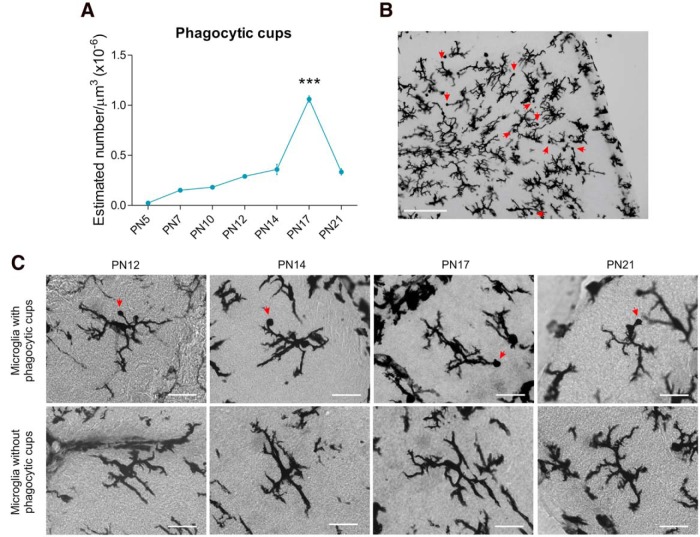
Microglial phagocytosis in the postnatal developing cerebellum. A, The highest density of phagocytic cups was observed during the third postnatal week at P17 (***p < 0.000 compared with P5, P7, P10, P12, P14, and P21; n = 4, 2 males + 2 females for each group). Data are expressed as mean ± SEM. B, Phagocytic cups exhibited by microglia (red arrows) in the developing cerebellum at P17. Scale bar, 100 µm. C, Microglia with phagocytic cups (top) or microglia without phagocytic cups (bottom row) at different time points during postnatal development. Scale bars, 25 µm.